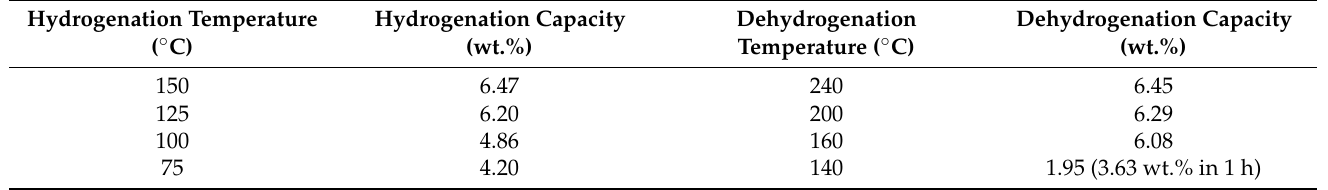
Table 1. The initial hydrogenation temperature and de/hydrogenation capacity of MgH 2 -6 wt.% ML-Ti 3 C 2 . Hydrogenation